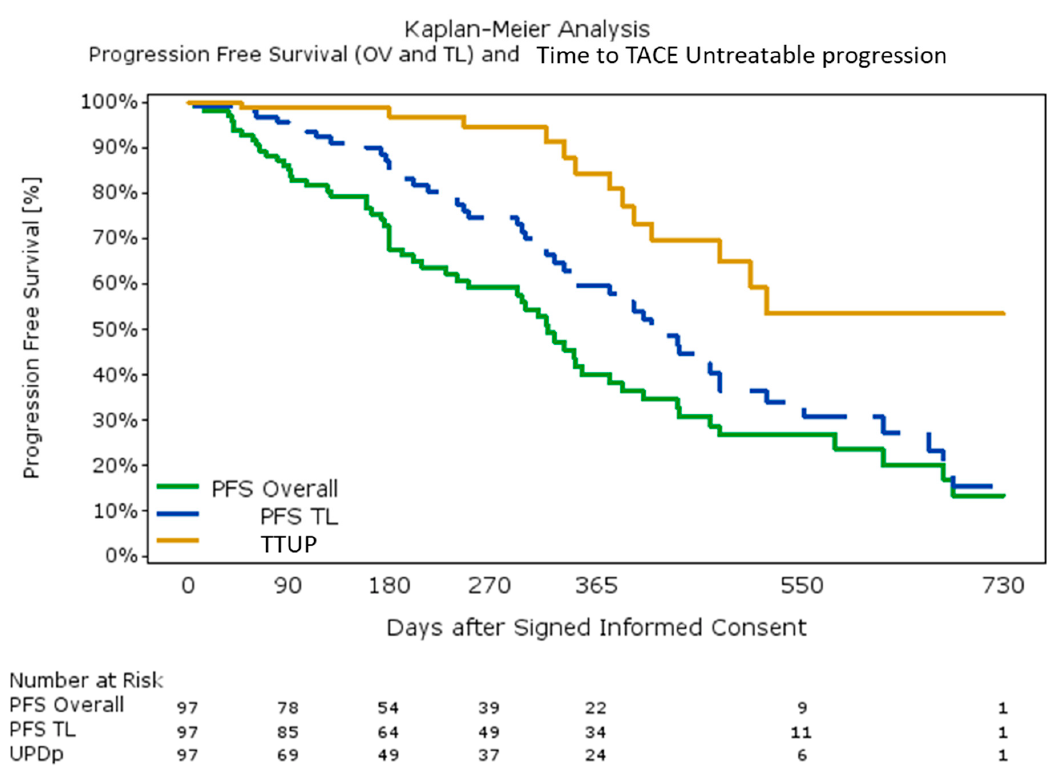
Figure 2. Kaplan–Meier Analysis: progression free survival (overall and target lesion) and time to transarterial chemoembolization (TACE) untreatable